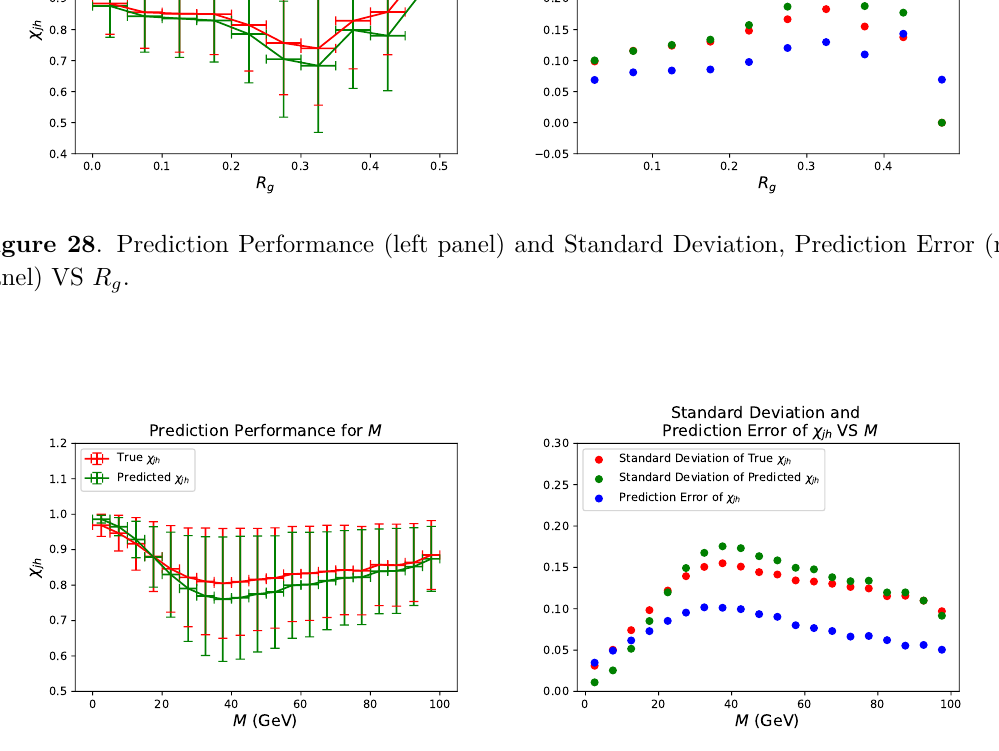
Figure 29 . Prediction Performance (left panel) and Standard Deviation, Prediction Error (right panel) VS M .